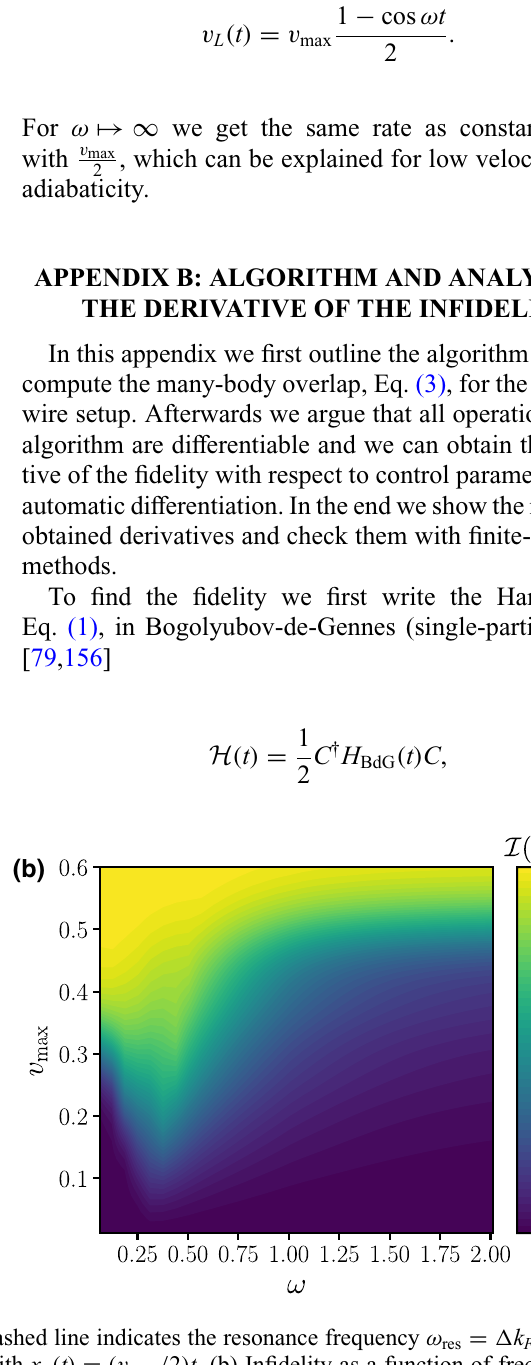
( t ) = (v / 2 ) t . (b) Infidelity as a function of frequency and max L